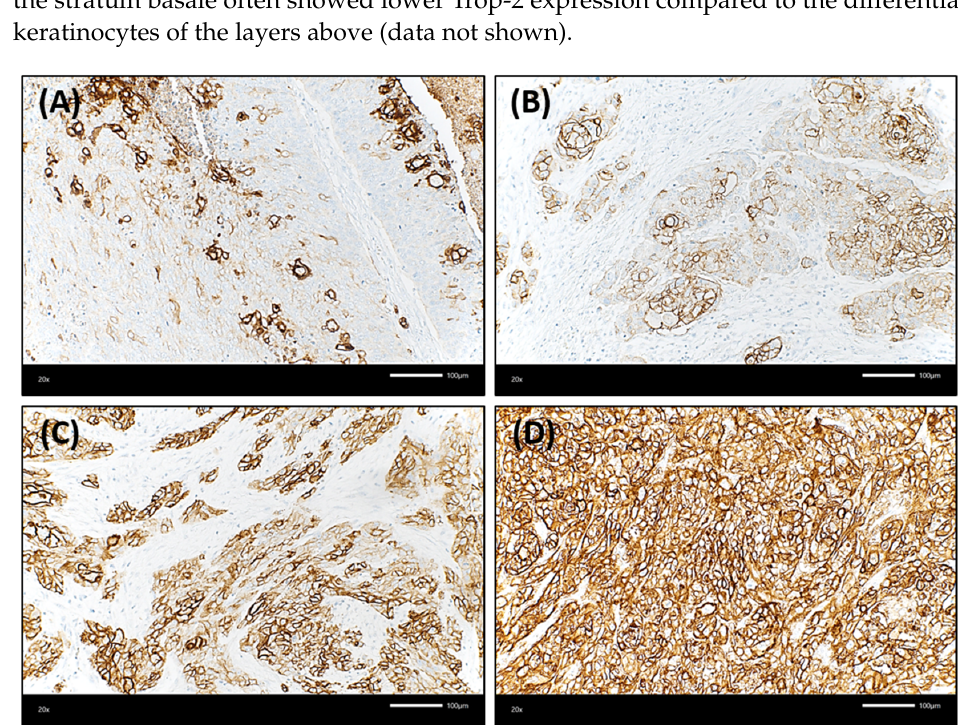
Figure 1. Membranous staining of Trop-2 in oral squamous cell carcinoma (OSCC) using immuno- histochemistry (Trop-2 immunohistochemistry, × 200 magnification). OSCC cases presented with membranous Trop-2 expression; however, the intensity and percentage of positively stained cancer cells was variable. ( A , B ): Few OSCC samples showed with overall low but heterogenous Trop-2 expression, with multiple cancer cells presenting with a loss of or only low Trop-2 staining admixed with tumor cells with strong Trop-2 staining intensity (H-score of 75 and 100, respectively). ( C ): OSCC with heterogenous but medium Trop-2 expression (H-score = 175). Single cells present with very low staining. ( D ) Homogenous, medium Trop-2 expression of an OSCC case (H-score = 190). ( E , F ): Two OSCC with high Trop-2 expression (H-scores ≥ 240). The tumor cells show a strong and membranous Trop-2 staining intensity.